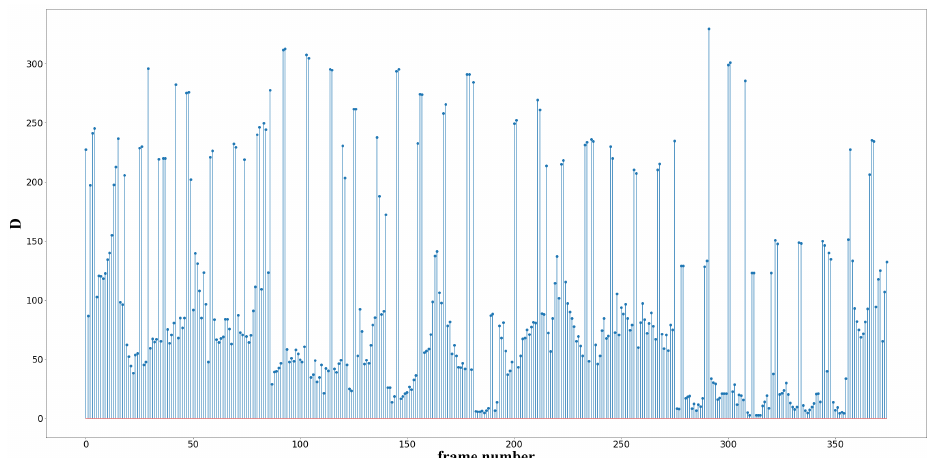
Figure 5. Interframe difference after equal interval extraction.